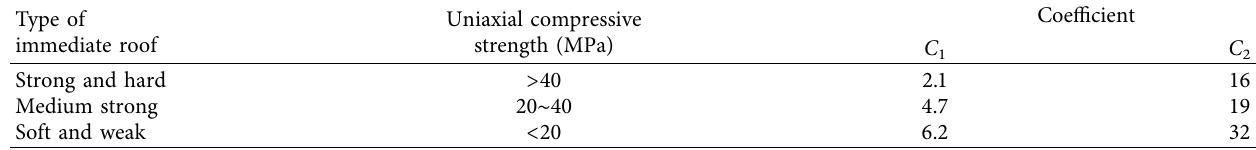
Table 2: Values of the coefficients C 1 and C 2 for various stratum